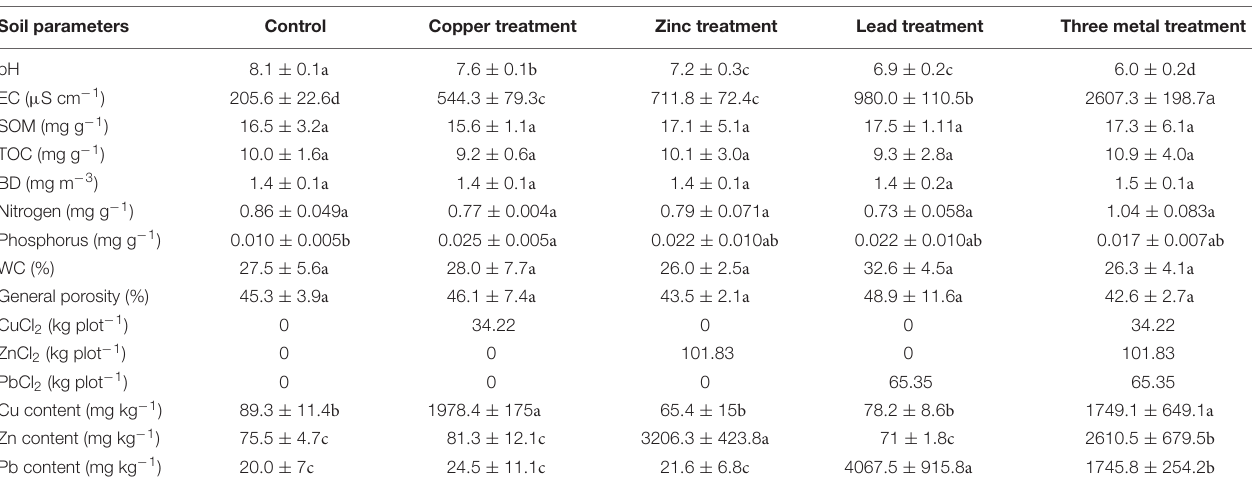
FIGURE 1 | Field design. (A) Split-plot experimental design comprising four blocks divided in five 10 m × 10 m plots, each corresponding to one of the five treatments: control soil (C) or soil spiked with Cu, Pb, Zn, or a mix of all three metals (3M). (B) The mean concentration of spiked metals across each of the five treatments at the time of sampling for DNA extraction and 16S rRNA gene amplicon analysis (error bars = standard error of four blocks per treatment). Asterisk “ ∗ ” represents statistical difference from control soil for a given metal ( t -test, p < 0.05). TABLE 1 | Soil physiochemical